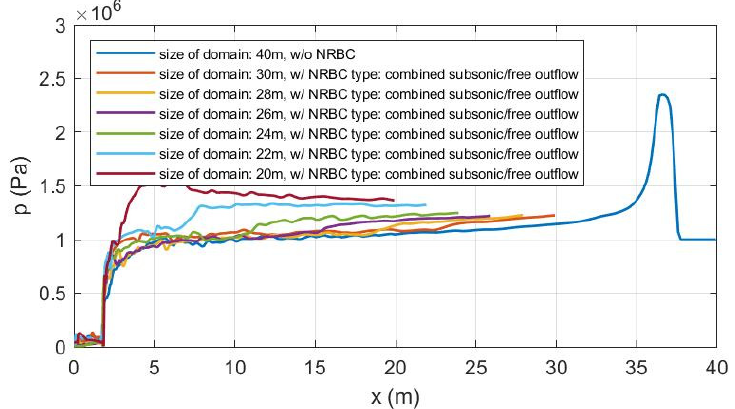
Figure 27. Mixed free/subsonic outflow type of NRBC, and its performance.